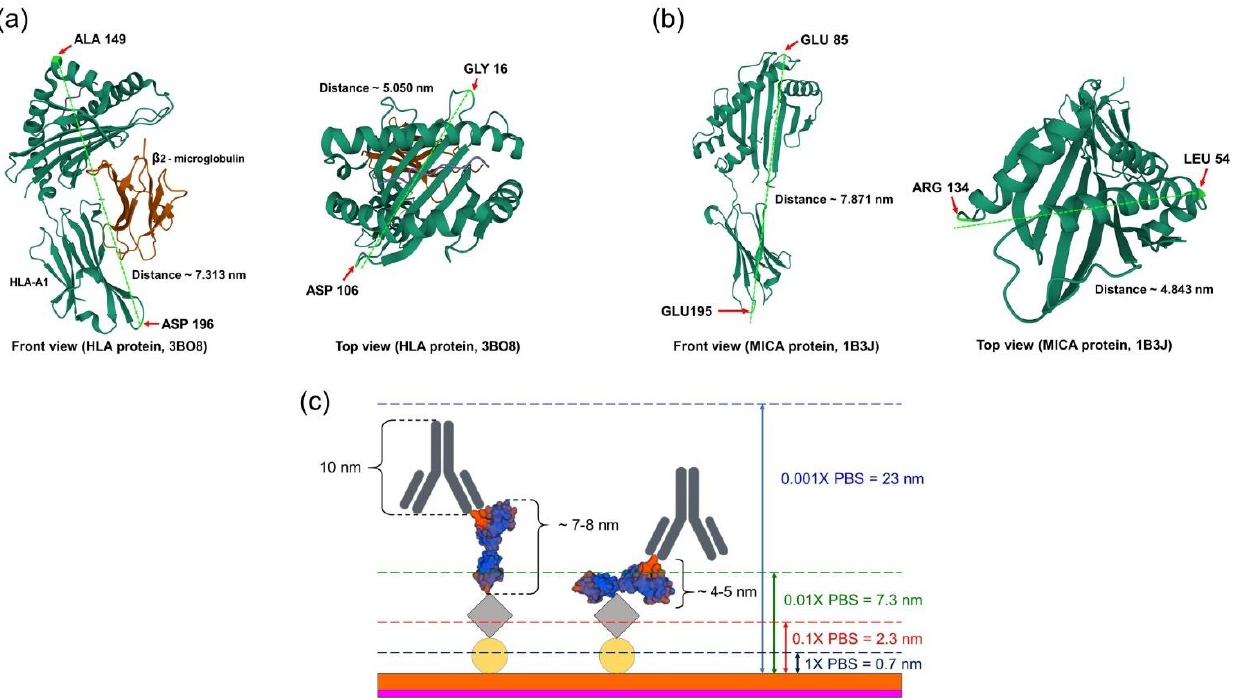
∆ V gs was obtained